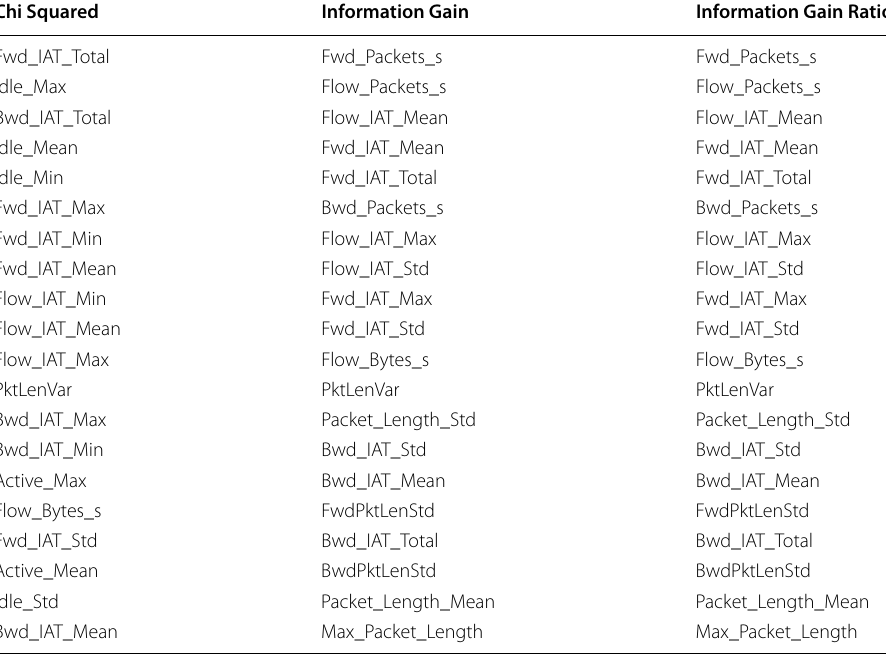
Table 16 Top 20 features for SQL Injection web attacks ranked by Filter-based techniques Chi Squared